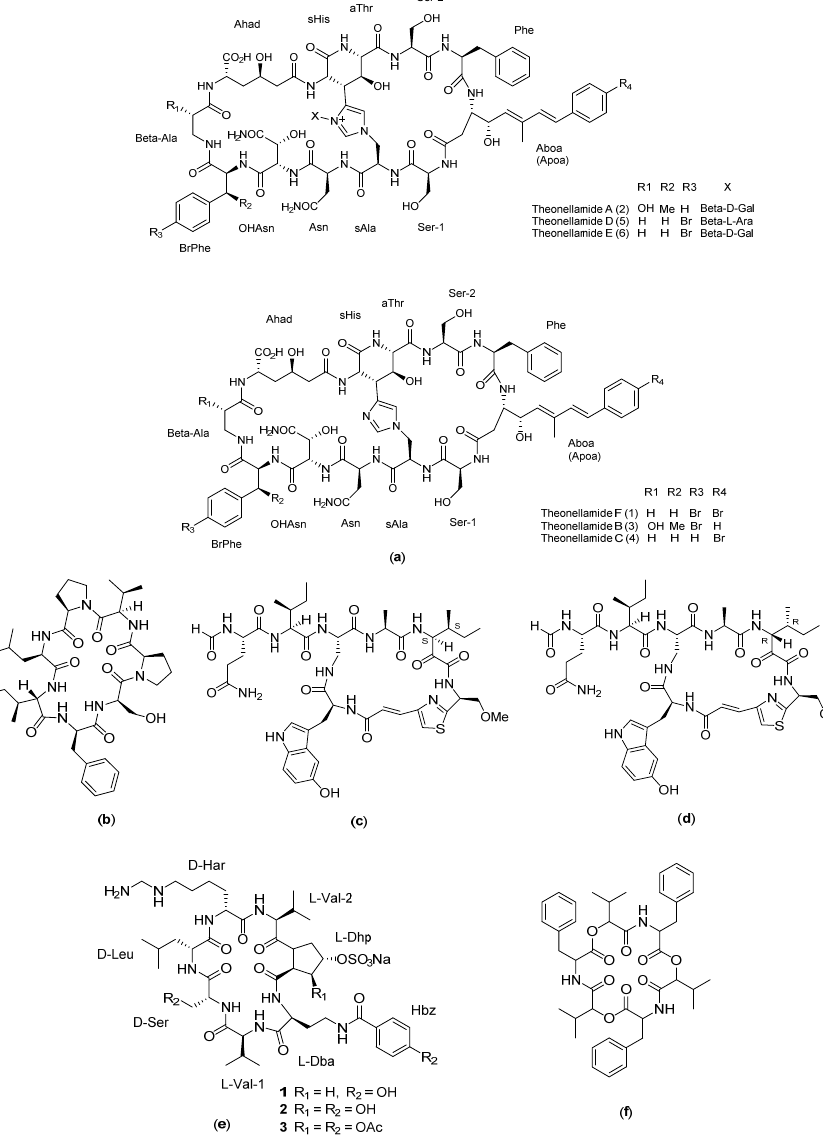
Figure 10. Structure of: ( a ) Theonellamide; ( b ) Stylopeptide 1; ( c ) Calyxamide A; ( d ) Calyzamide B; ( e ) Cupolamide; and ( f ) Beauvericin.